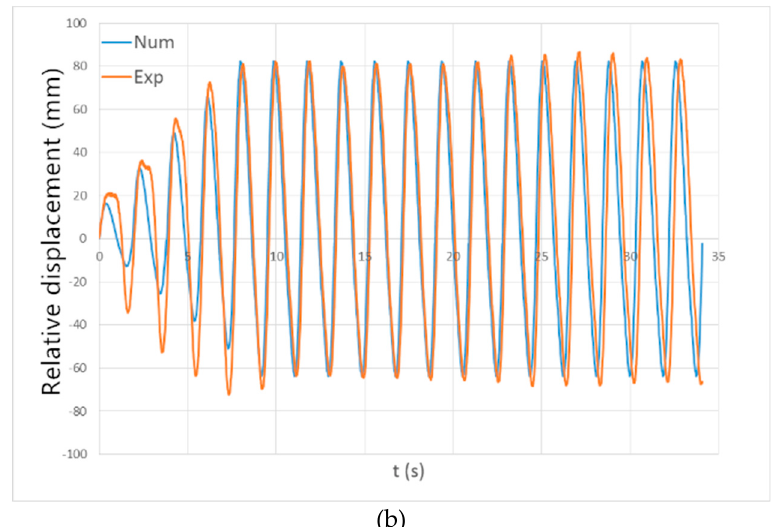
Figure 11. The motion comparison of the moonpool platform wave energy converter (MPWEC) with CFD results in time domain. ( a ) T = 2.0 s; (b) T = 2.2 s.